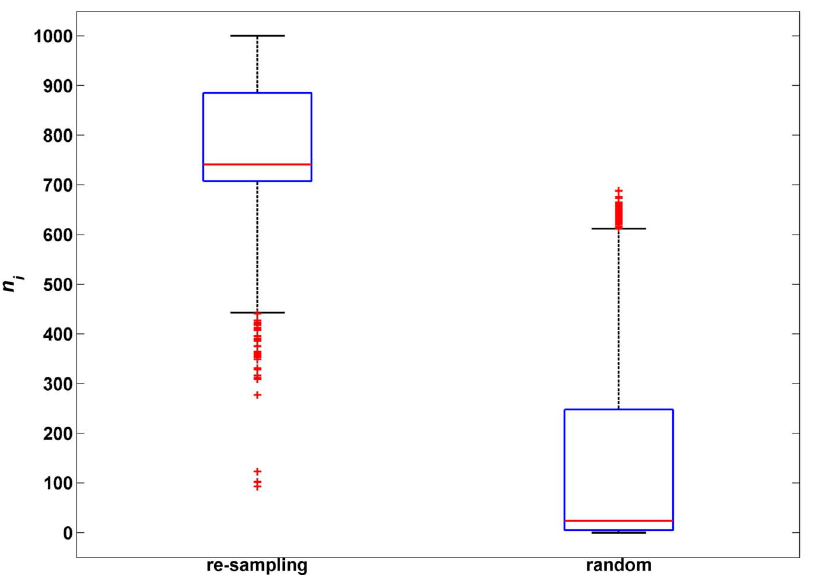
Figure 4. Comparison between re-sampling and random experiments to investigate the robustness of the bipartite network. Two box graphs represent the re-sampling experiments (left) and the random experiments (right), n i means the time of predicted association g i , q i ð Þ can be also predicted in re-sampling experiments and random